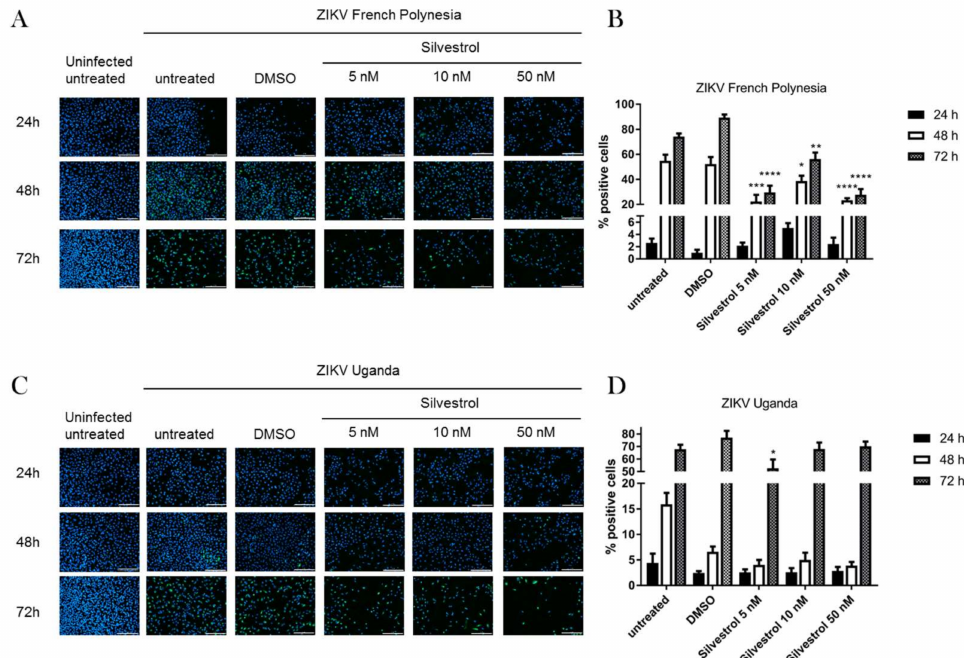
Figure 2. Silvestrol treatment reduces the number of Zika virus (ZIKV) positive cells. ( A ) A549 cells were infected with ZIKV French Polynesia isolate (FP) and treated with the indicated amount of silvestrol. Cells were fixed on the indicated time points and nuclei were stained with DAPI (blue) and NS1 was stained with a specific antibody in green, scale bar = 200 µ m; ( B ) Ratio of NS1-positive cells in at least four fields of view of the respective samples exemplary shown in ( A ); ( C ) A549 cells were infected with ZIKV Uganda isolate (U) and treated with the indicated amount of silvestrol. Cells were fixed on the indicated time points and nuclei were stained with DAPI (blue) and NS1 was stained with a specific antibody in green, scale bar = 200 µ m; ( D ) Ratio of NS1-positive cells in at least four fields of view of the respective samples exemplary shown in ( C ). * = p ≤ 0.05; ** = p ≤ 0.01; *** = p ≤ 0.001; **** = p ≤